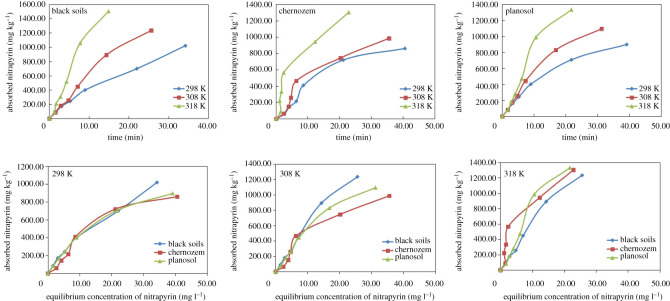
Adsorption isotherm curves.